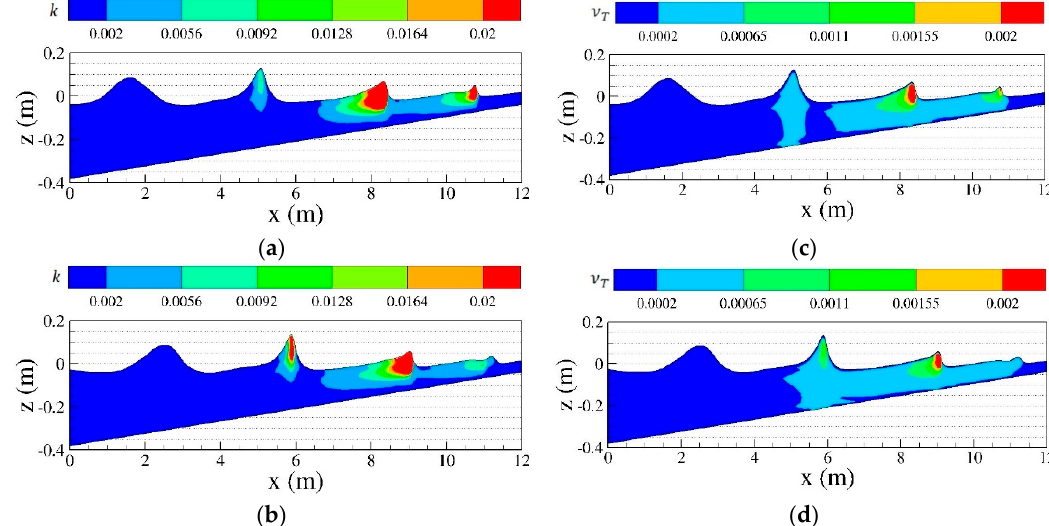
Figure 8. Ting and Kirby [21] spilling breaking wave test case. Instantaneous spatial distribution of the turbulent kinetic energy ( a,b ) and the turbulent eddy viscosity ( c,d ) in two different time steps, obtained by the Gallerano et al. [14] numerical model in which the turbulence model is the proposed modified 𝑘 − 𝜀 .